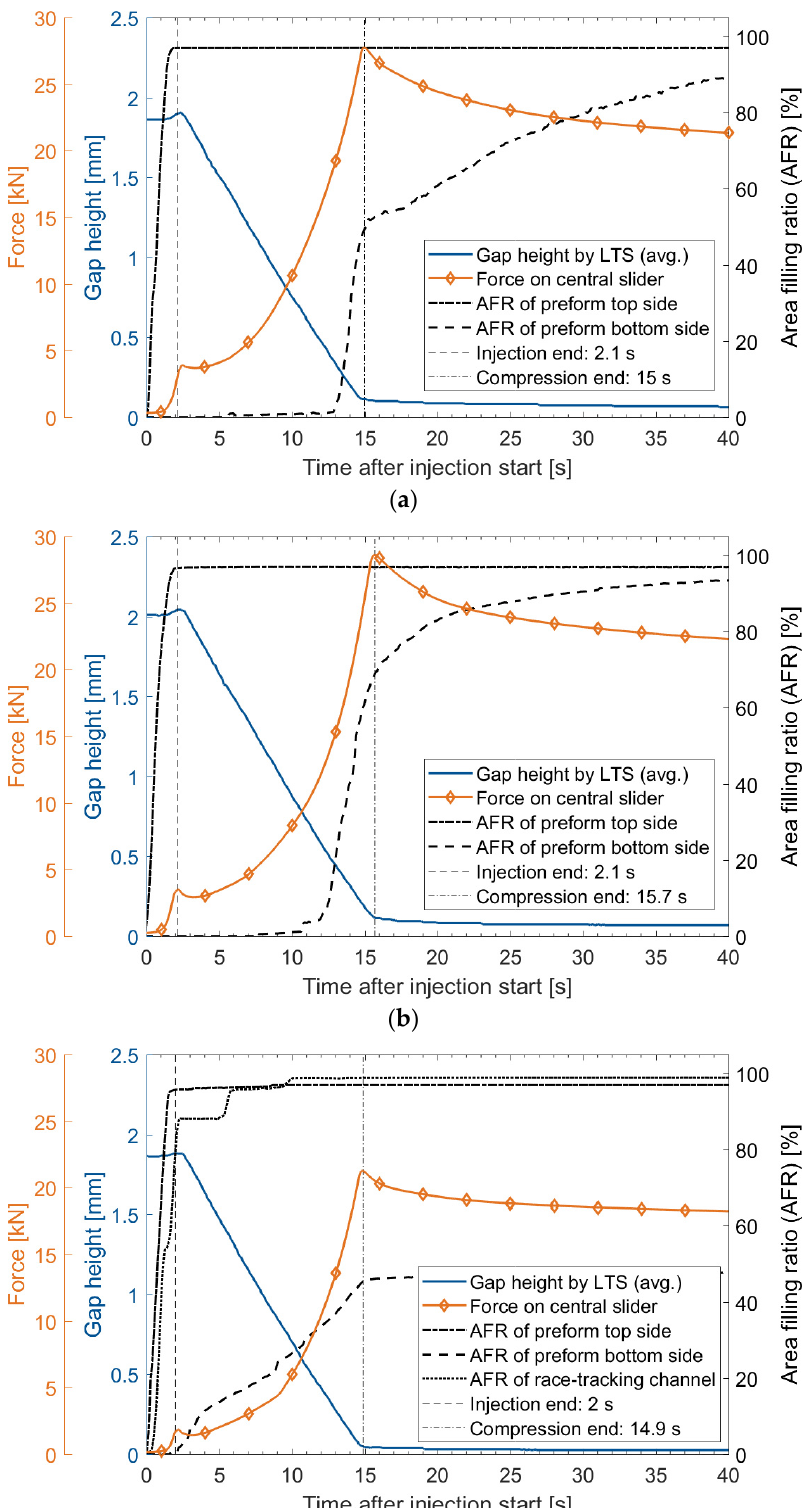
Figure A3. Overview of important process variables during FS-CRTM experiments of the race- tracking study: ( a ) no race-tracking channel—vc-#1; ( b ) no race-tracking channel—vc-#2; ( c ) medium race-tracking channel width—mrt-#1 (LTS = laser triangulation sensor).